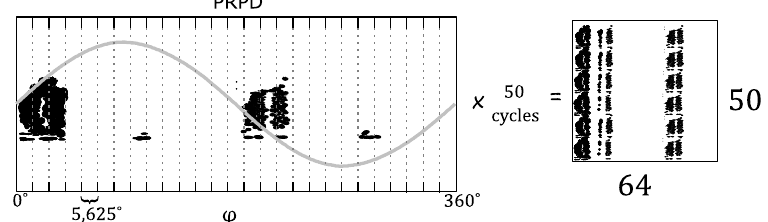
Figure 7. PRPD data used as input data for the Deep Neural Network (DNN), adapted from [14].